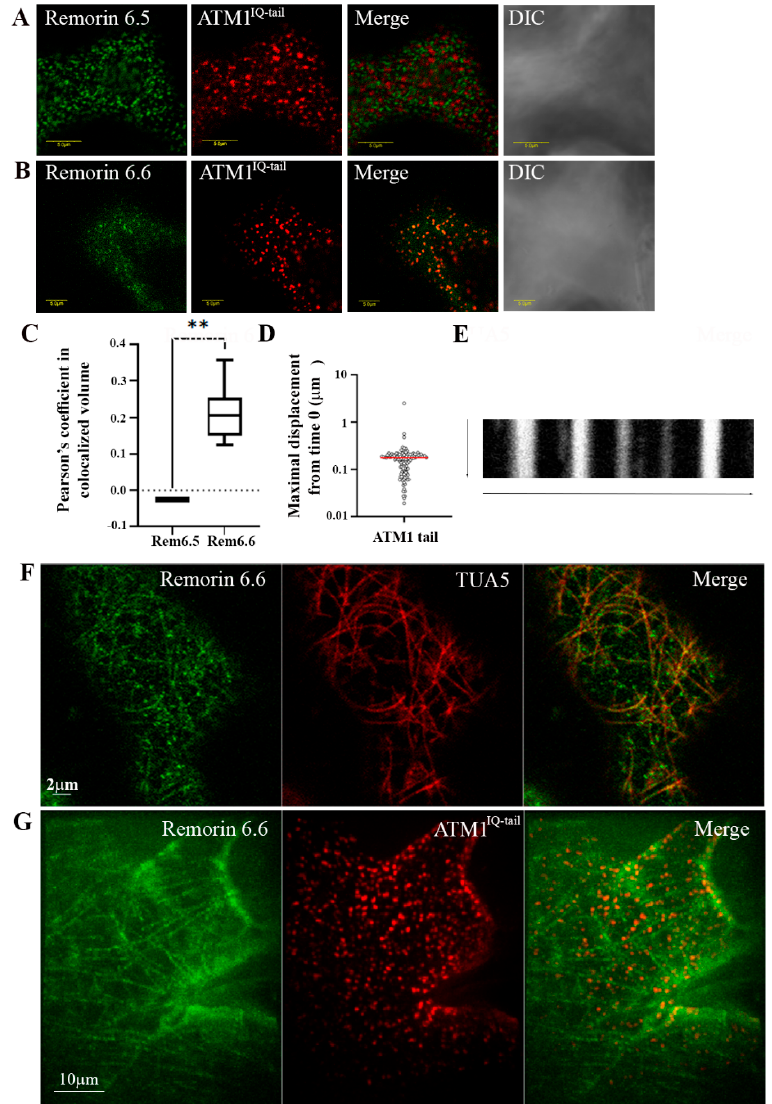
Figure 1. Myosin VIII ATM1 IQ-tail colocalizes with remorin 6.6 labeled structures. ( A ) Negative colocalization with remorin 6.5. ( B ) Colocalization with remorin 6.6. ( C ) Pearson’s coefficient analysis of colocalization. Differences were analyzed by T -test ** p < 0.01. ( D ) Kymograph showing lateral stability of ATM1 IQ-tail ; Y axis—50 frames, 2 sec intervals, X axis—10 μ m. ( E ) Maximal displacement from position in time 0, of each ATM1 IQ-tail spot, during 50 frames, 2 sec intervals in 3 cells. ( F ) Partial alignment of GFP-remorin 6.6 with MTs labeled with mCherry-Tubulin α 5 in A. thaliana . ( G ) No pronounced colocalization of mCherry-ATM1 IQ-tail with GFP-remorin 6.6 along MTs, in N. benthmiana . In this work, we addressed the question whether clusters of membrane associated ATM1 IQ-tail affect MTs positioning in the cortex of epidermal cells. For this 35S-mCherry- ATM1 IQ-tail [22,23] was transiently expressed in 35S-GFP-TUA6 stably expressing N. ben- thamiana plants [42], and its distribution in the cells was followed by live cell imaging